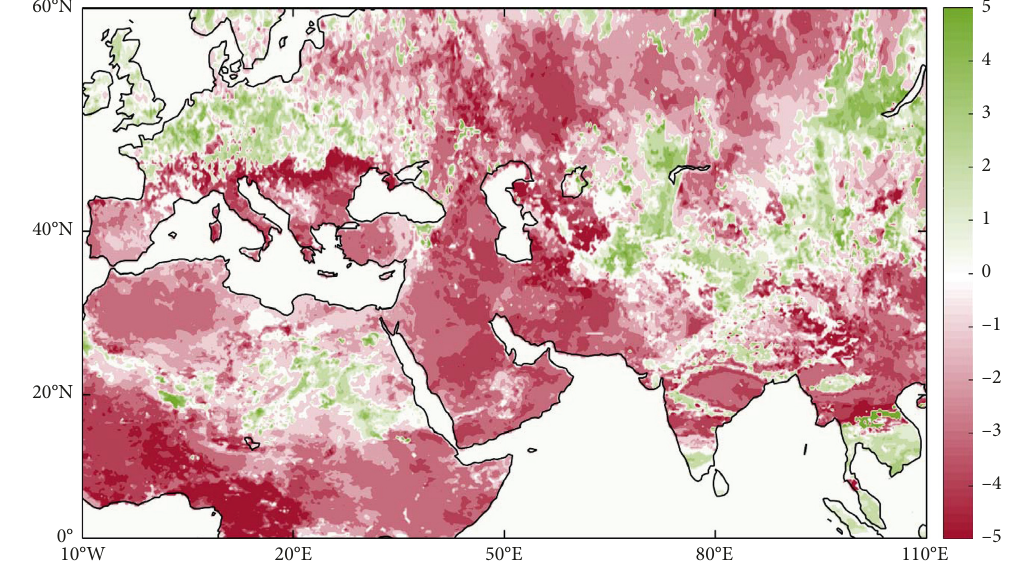
Figure 3: Monthly average scPDSI in 1998.